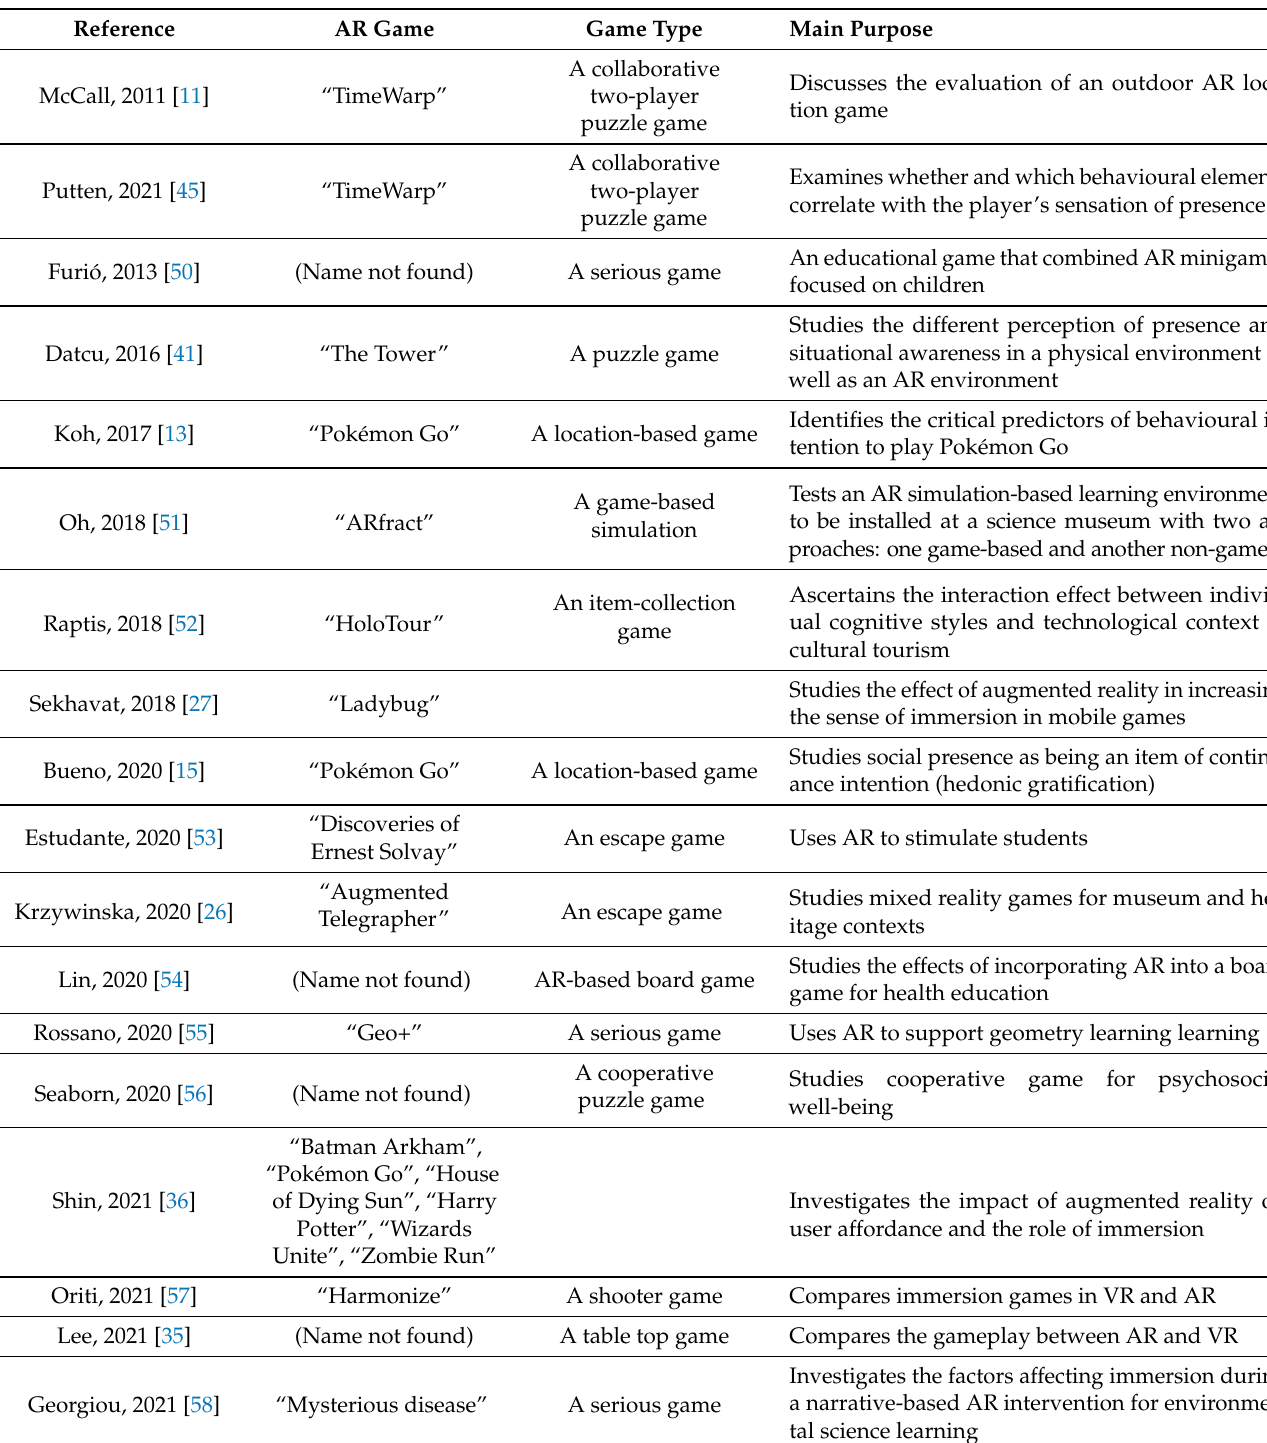
Table 3. The summary of the analysed records referring to the main purpose of each study. Note that the game type column refers to the specifics of each game and not the genre since all of them are AR games according to the game genre categorisation of Scott Rogers